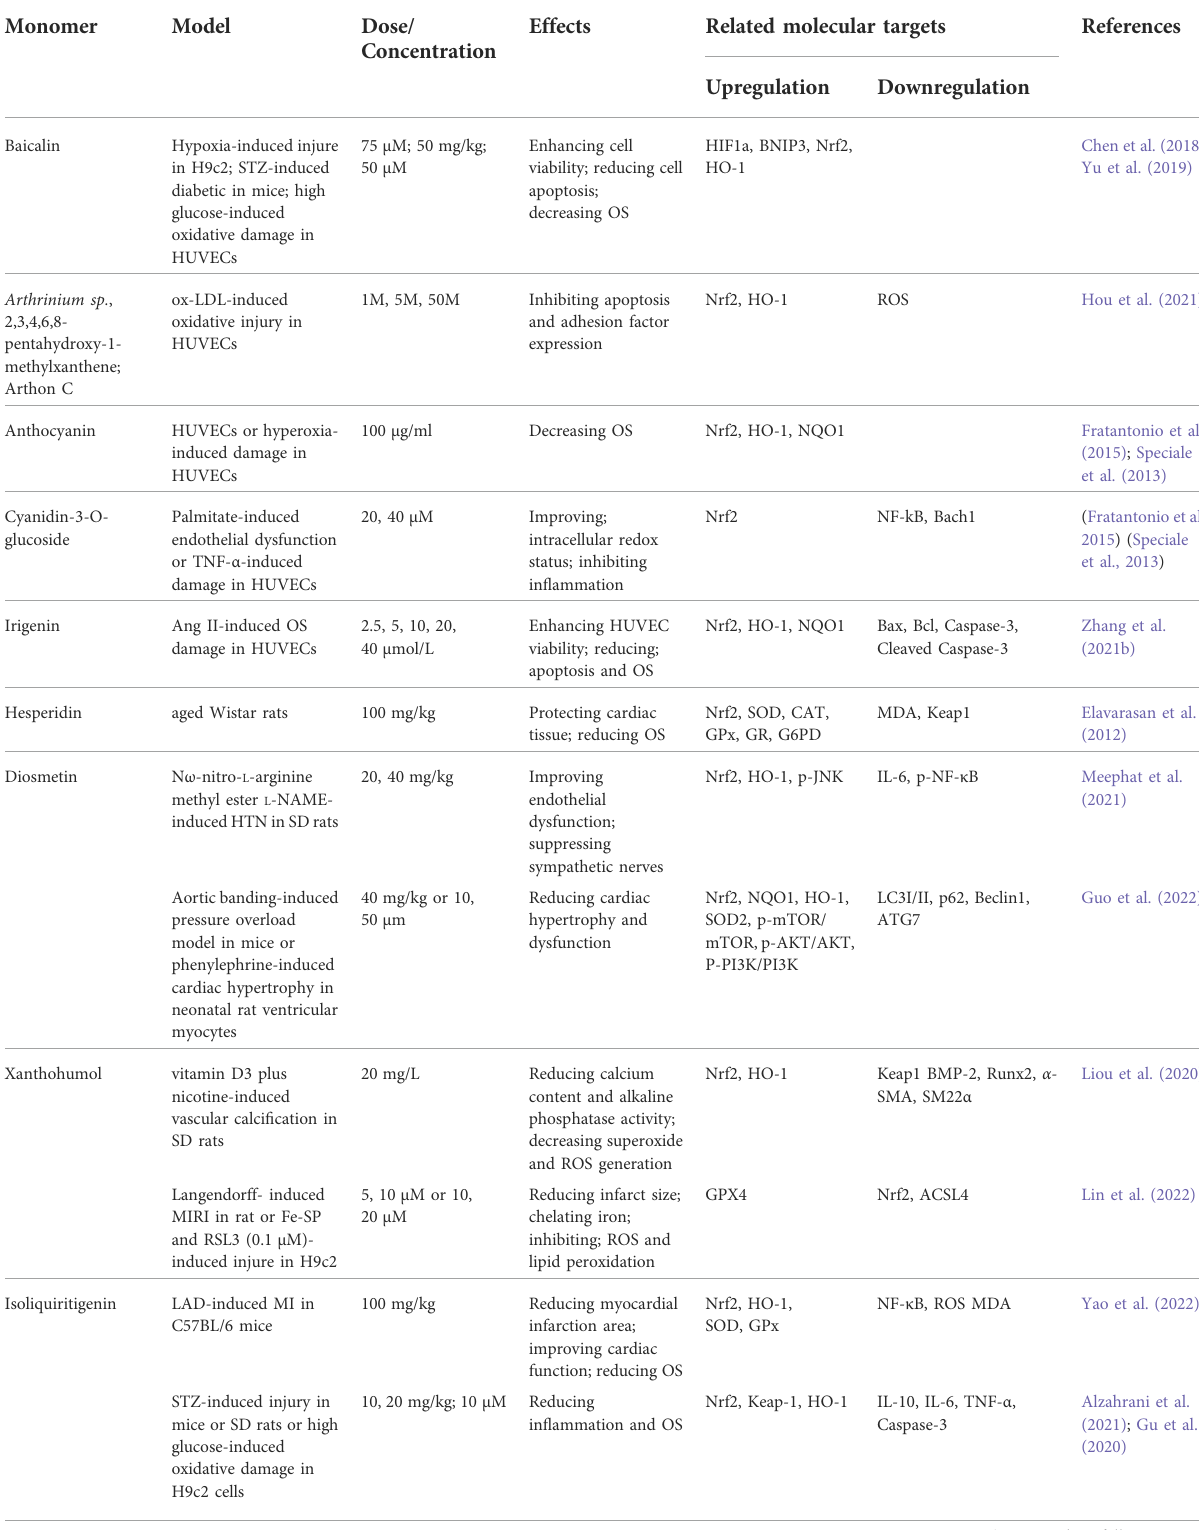
TABLE 2 Protective effects of fl avonoids on vascular endothelial